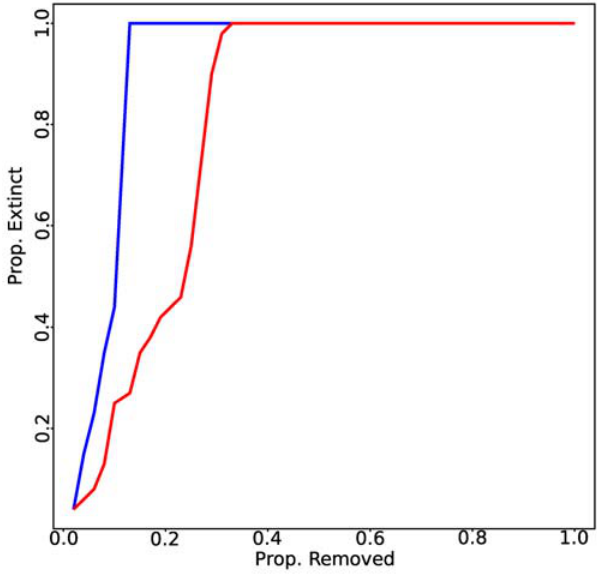
Figure 2. The extinction area is the area described by the area below the curves. The area can take values from 1 extinctions in response to the removal of species) to 1 (all species go extinct after the first removal). The x axis represents the fraction of species removed in the numerical experiment, while the y axis is the fraction of species that are extinct as the result of these removals. The example uses the St. Mark’s food web [29] and the D (red) and EIG (blue)